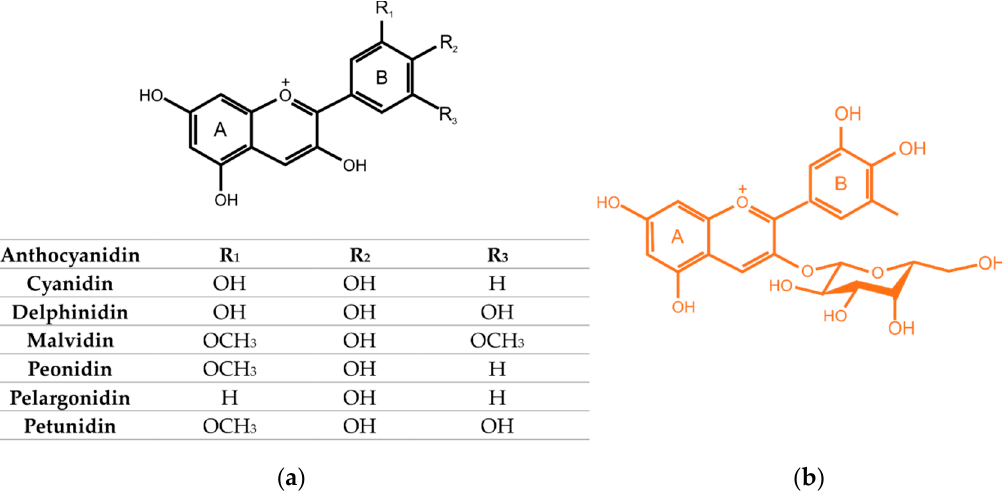
Figure 1. Chemical structure of most widespread anthocyanidins ( a ) and cyanidin 3-O-galactoside ( b ).